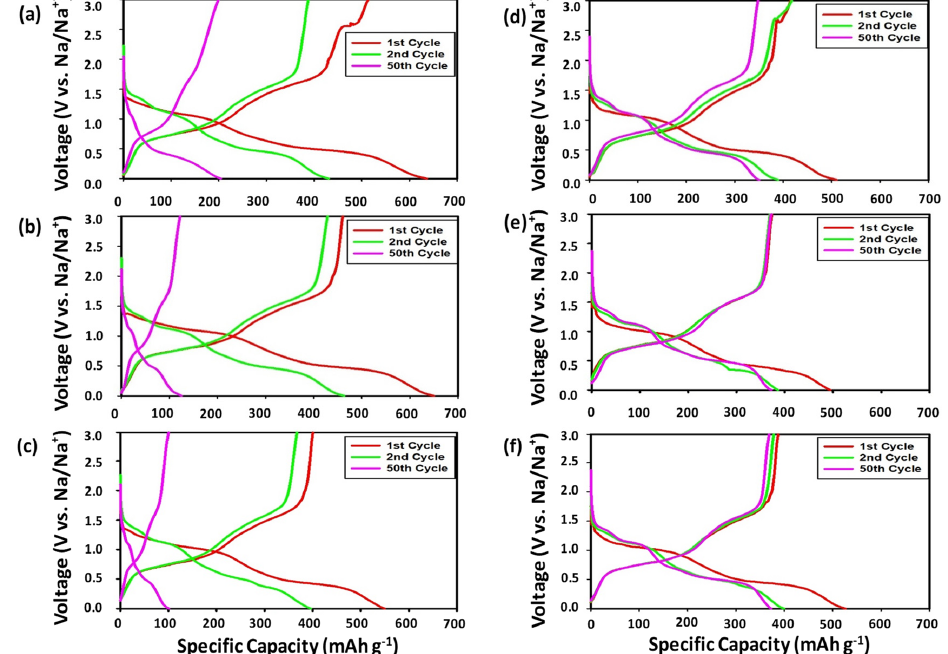
Figure 4. Voltage profiles of the SbTe-C30 electrode with ( a – c ) 0%, 2%, and 5% FEC (respectively) and the PVDF binder, and ( d – f ) 0%, 2%, and 5% FEC (respectively) and the PAA binder.